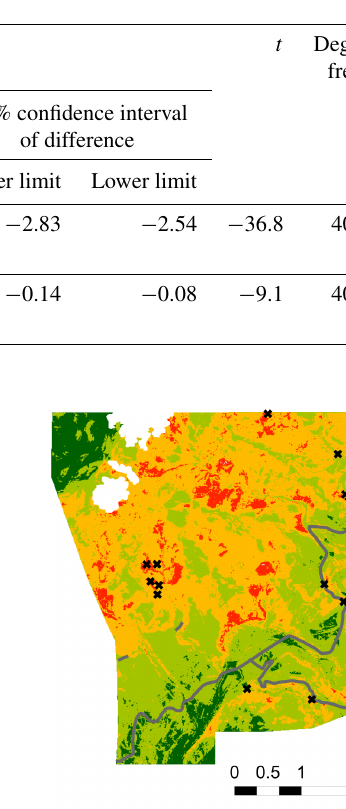
Table 6. Paired sample t test results between elevation and terrain roughness and slope gradient and slope roughness.